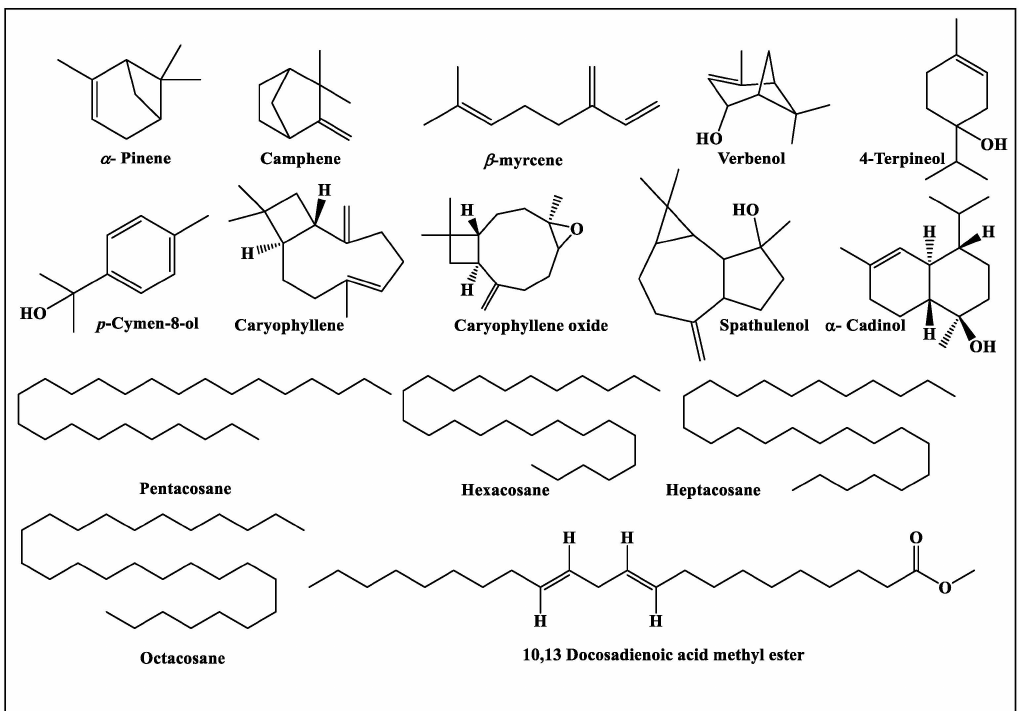
Figure 3. Main secondary metabolites in the Ferula